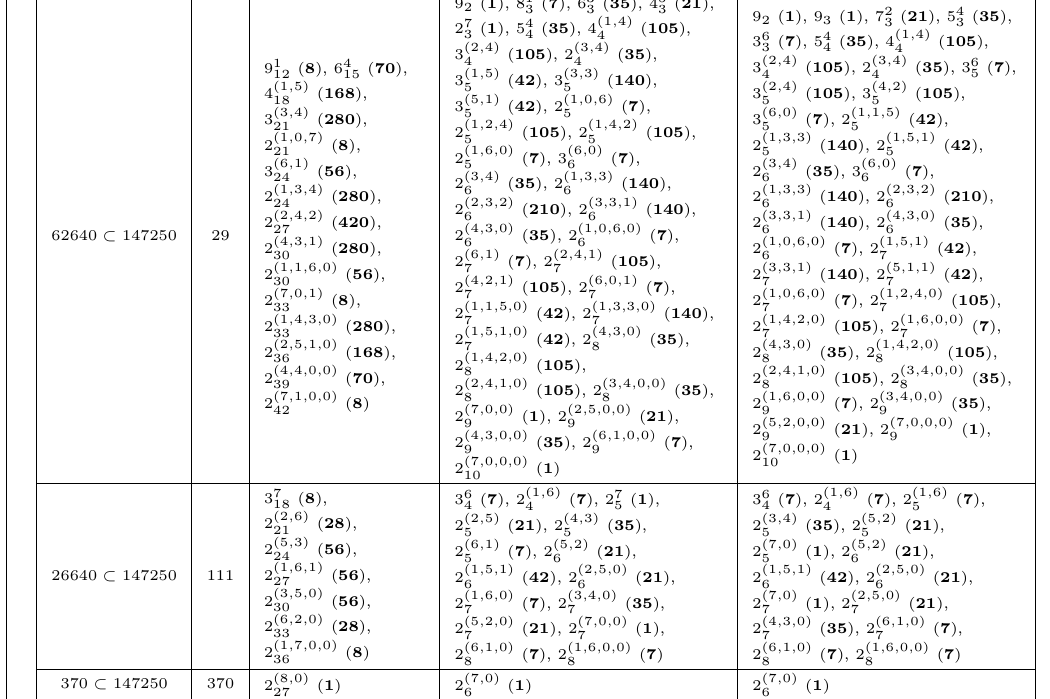
Table 17 . Missing states in the membrane multiplet.